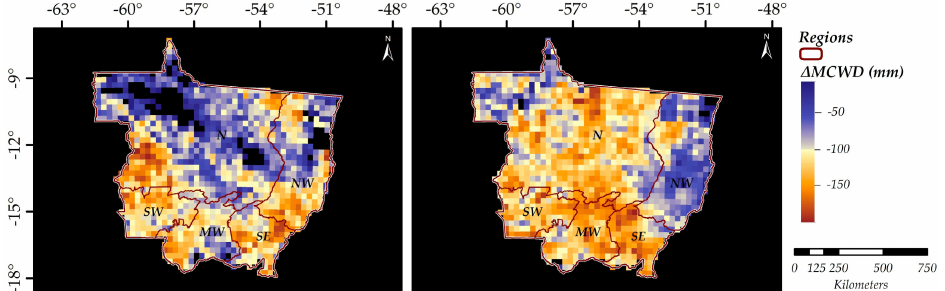
Figure 2. Increase in the maximum climatological water deficit in 2007 and 2010 for each region of the Brazilian state of Mato Grosso (N = North, NW = Northwest, MW = Midwest, SE = Southeast, SW = Southwest). Data obtained from the Tropical Rainfall Measuring Mission (TRMM) satellite [45]. Each pixel represents the di ff erence between the annual deficit and the historical value between 2001 and 2014 ( ∆